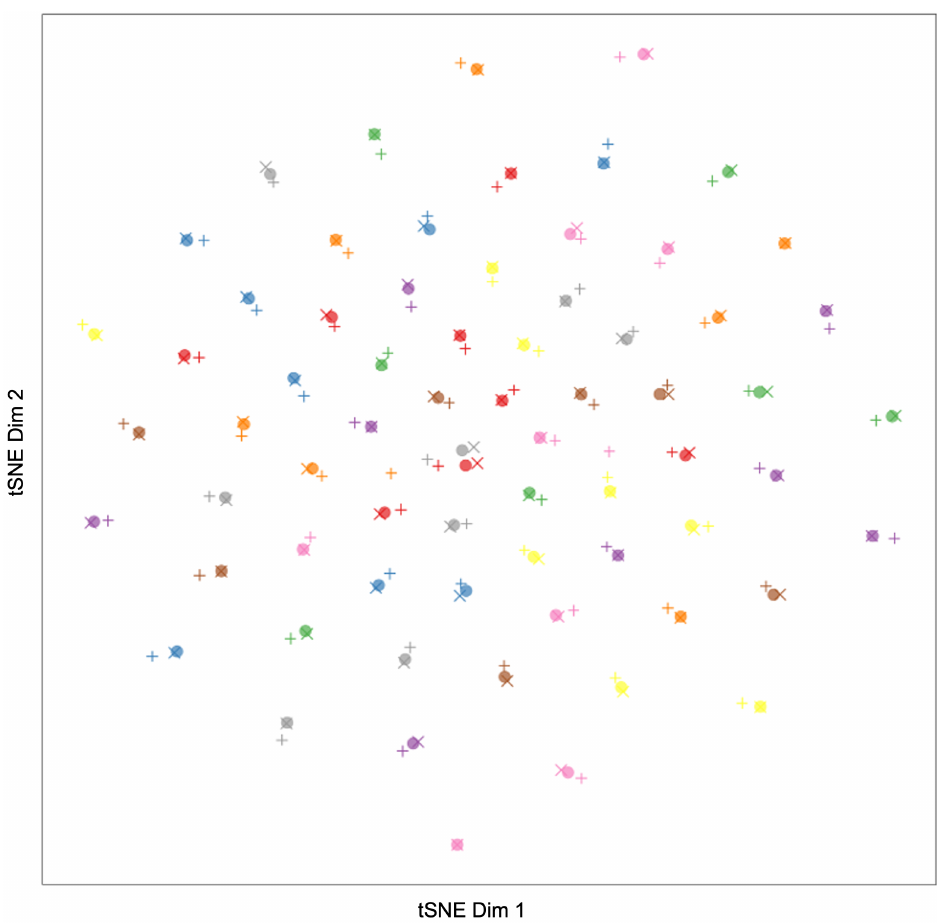
Figure 6. tSNE of facial embeddings from 69 individuals to show robustness to pose and occlusion. Frontal face images are represented with dots, askance images with +, and occluded images with × . Images from the same individual are shown as the same color (with some color reuse due to a limited color palette). Note the clustering of points relating to single identities regardless of occlusion or